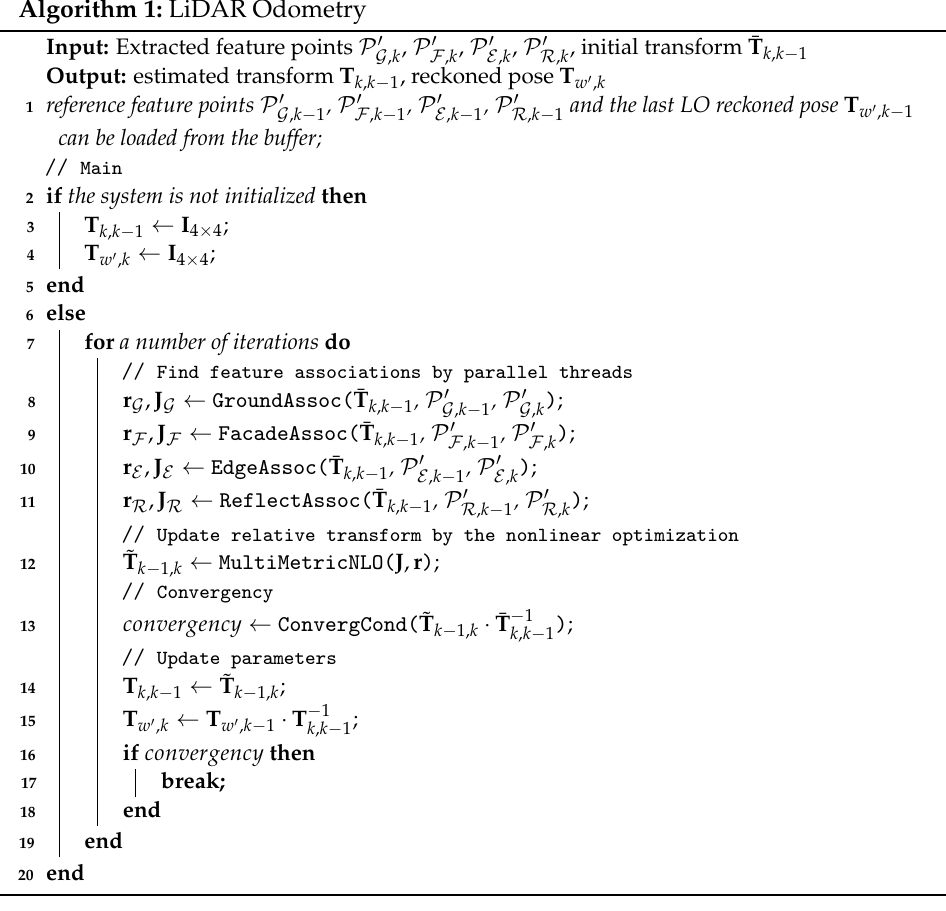
Algorithm 1: LiDAR Odometry